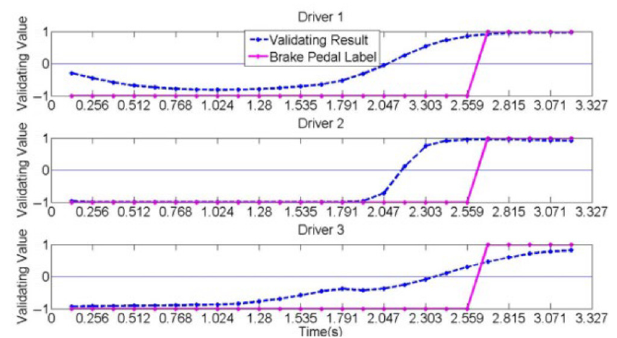
Figure 11 Veri fi cation results of the braking intention identi fi cation